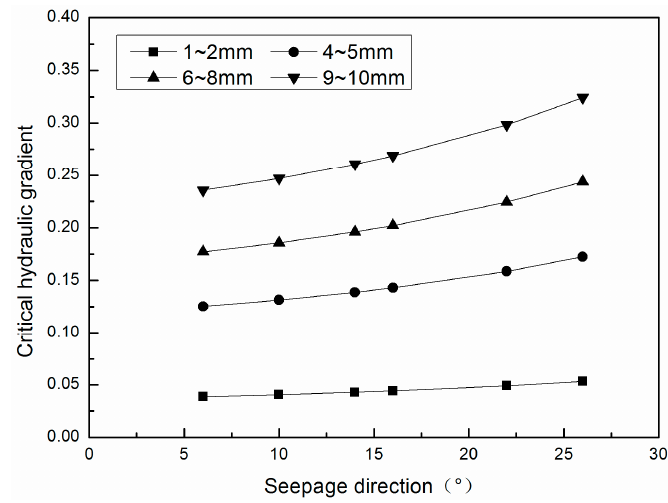
Figure 8. Effects of seepage direction on the critical gradients.